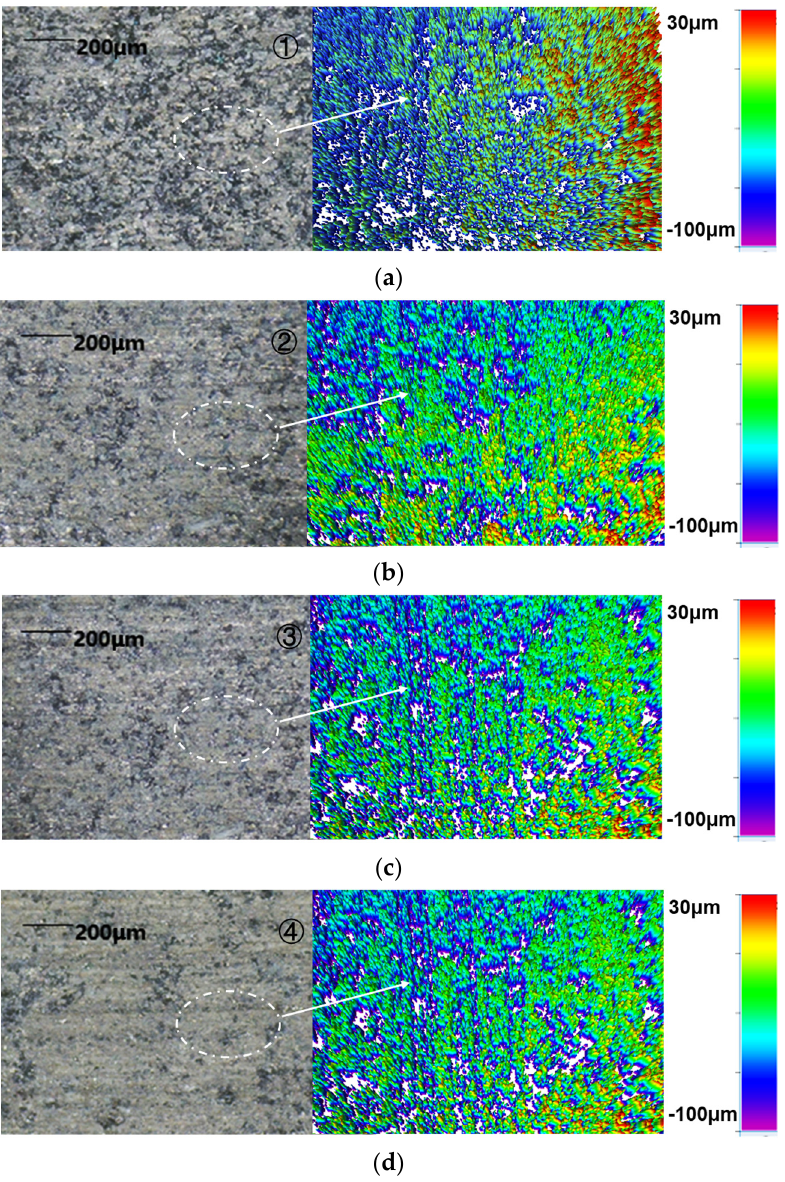
Figure 13. Resulting morphology for different feed rate voltage: ( a ) 3 V; ( b ) 4 V; ( c ) 5 V; ( d ) 6 V.